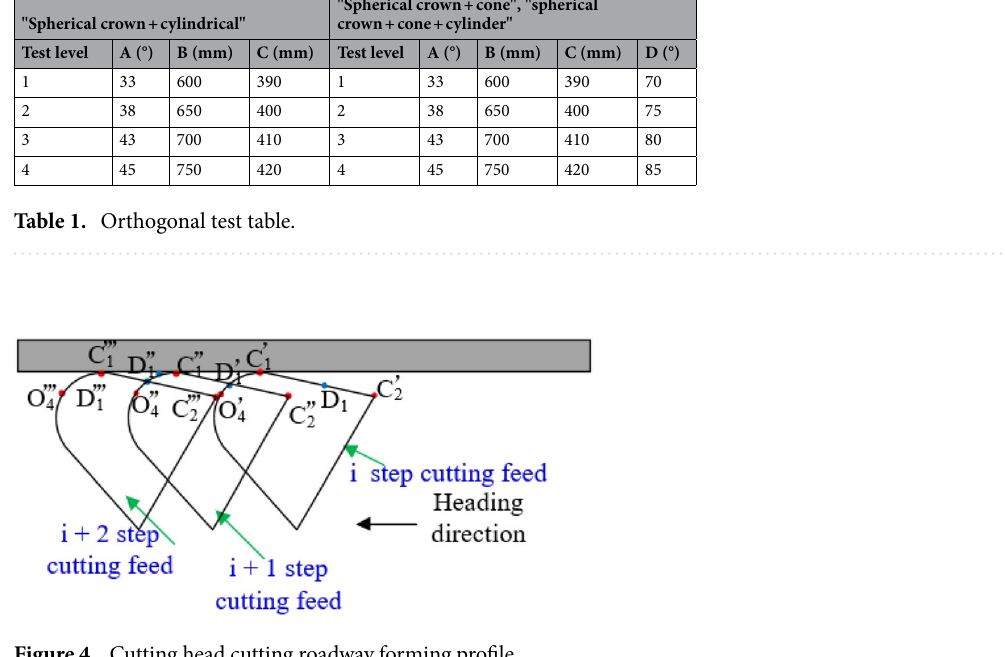
Figure 4. Cutting head cutting roadway forming